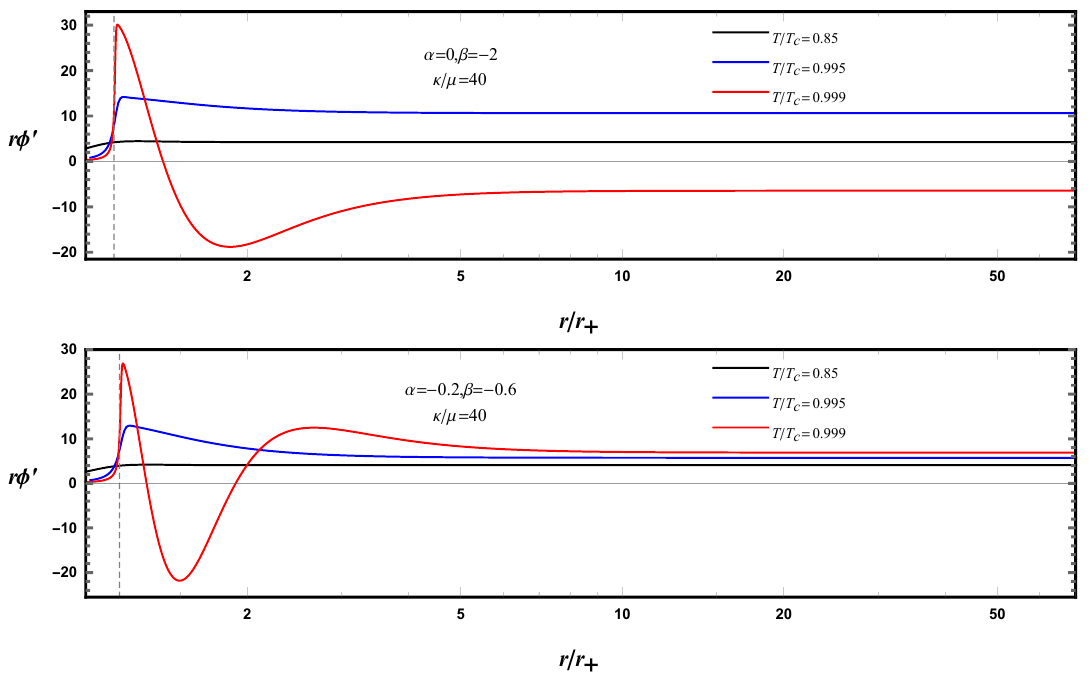
Figure 21 . Examples of the interior evolution. Black curves show the cases with no Josephson oscillations